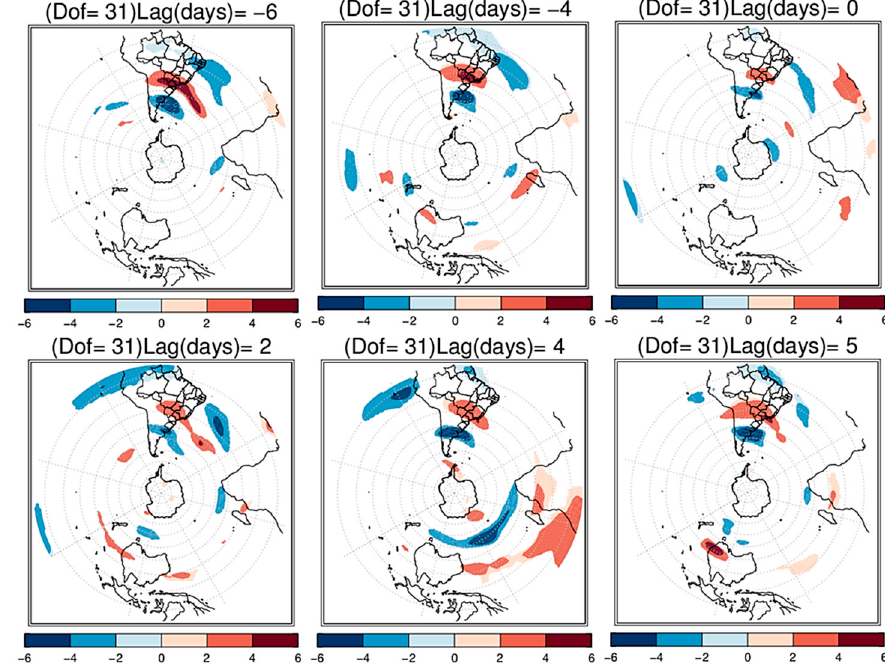
Figure 16. The same as Figure 15 but for AAO–.